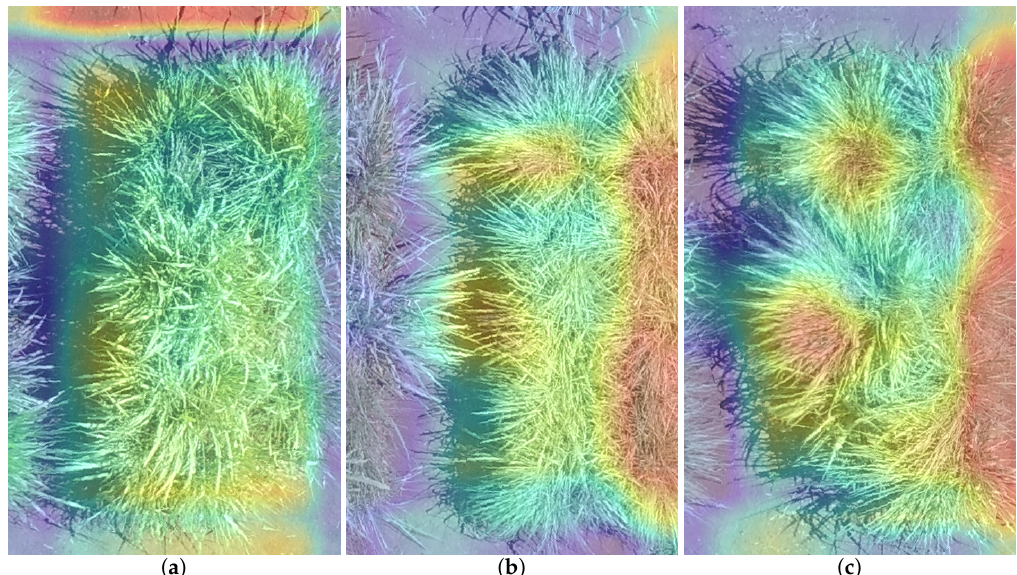
Figure 9. Heatmaps of the top 3 best predictions made by Experiment #9 (Pre-trained AlexNet Model with hv data augmentation): ( a ) First best prediction; ( b ) Second best prediction; ( c ) Third best prediction.